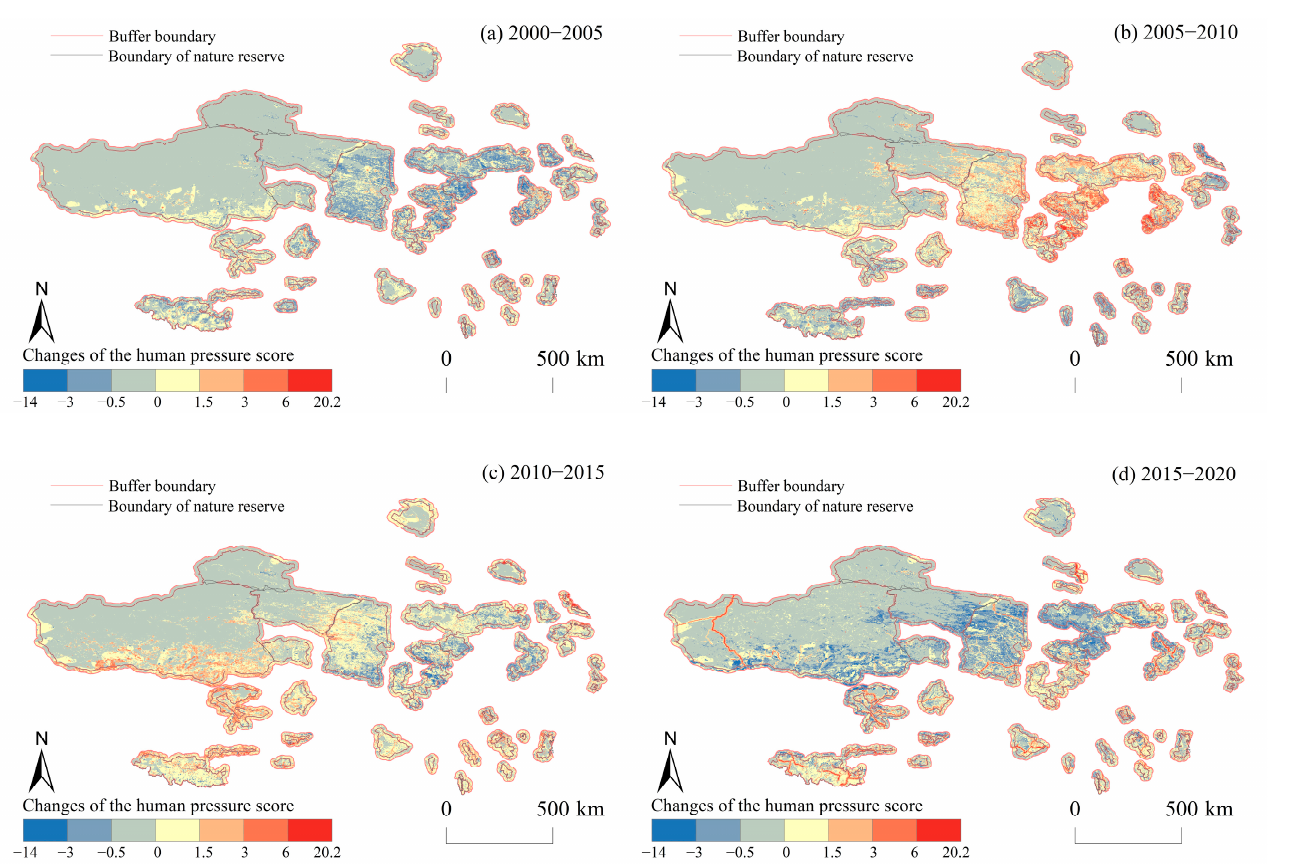
Figure 4. Spatiotemporal changes in HP inside and outside the NRs of the Qinghai–Tibet Plateau for 2000–2020.